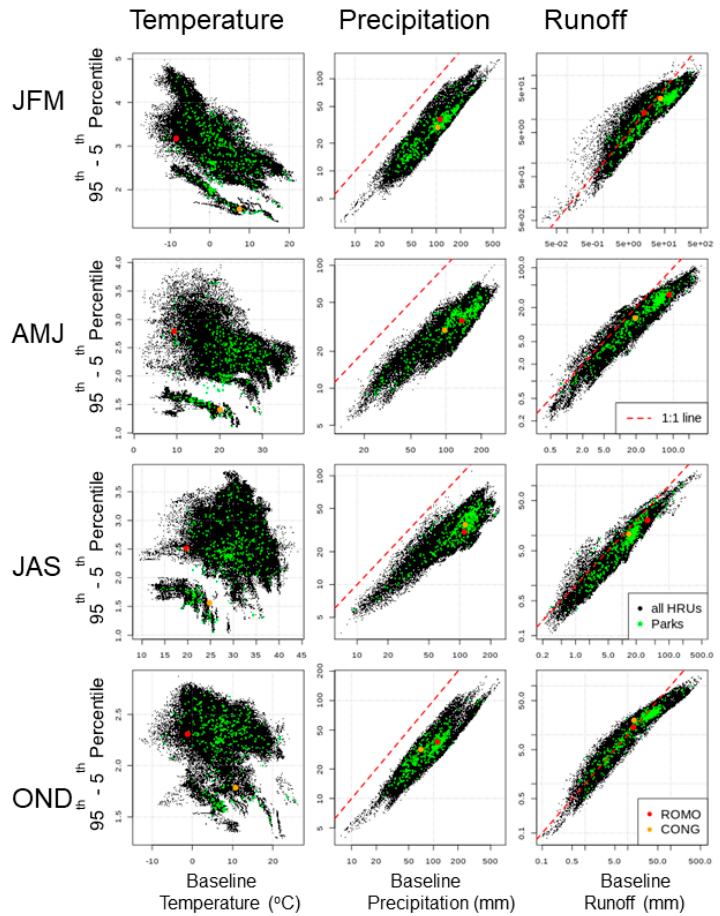
Figure 10. Comparison of baseline conditions to projected ranges (95th percentile − 5th percentile) of departures in seasonal average monthly temperature (°C), precipitation (mm), and runoff (mm), projected for 2030 by 214 climate simulations, for all HRUs in the CONUS (black dots), and for national parks in the CONUS (green dots). Note that x ‐ axis and y ‐ axis scales can vary by season and a log scale is used on the y ‐ axis for the precipitation and runoff plots. HRU, Hydrologic response unit; JFM, January–March; AMJ, April–June; JAS, July–September; OND, October–December; CONG, Congaree National Park; ROMO, Rocky Mountain National Park.